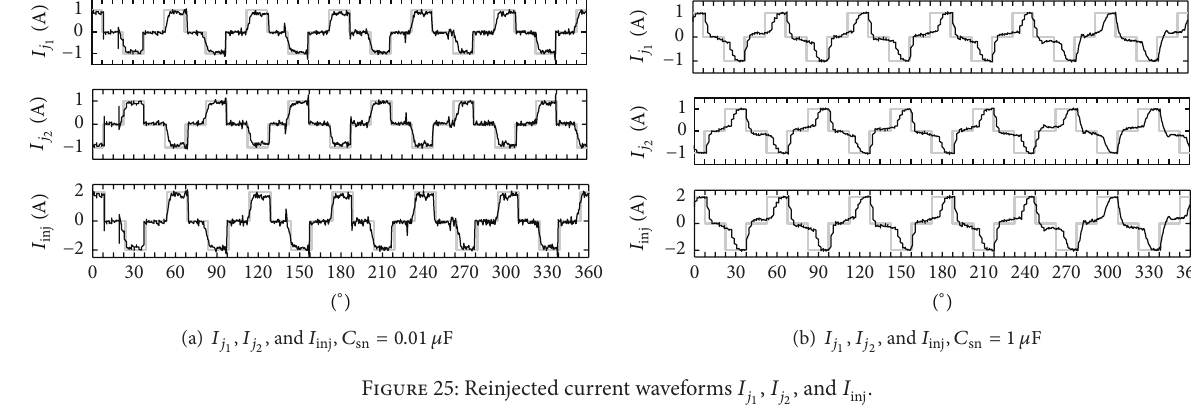
Figure 25: Reinjected current waveforms 𝐼 𝑗